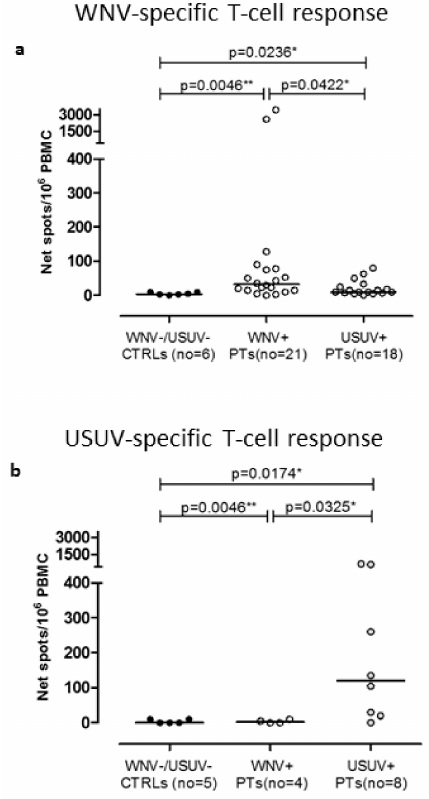
Figure 2. WNV-specific T-cell response was measured in six WNV − / USUV − healthy